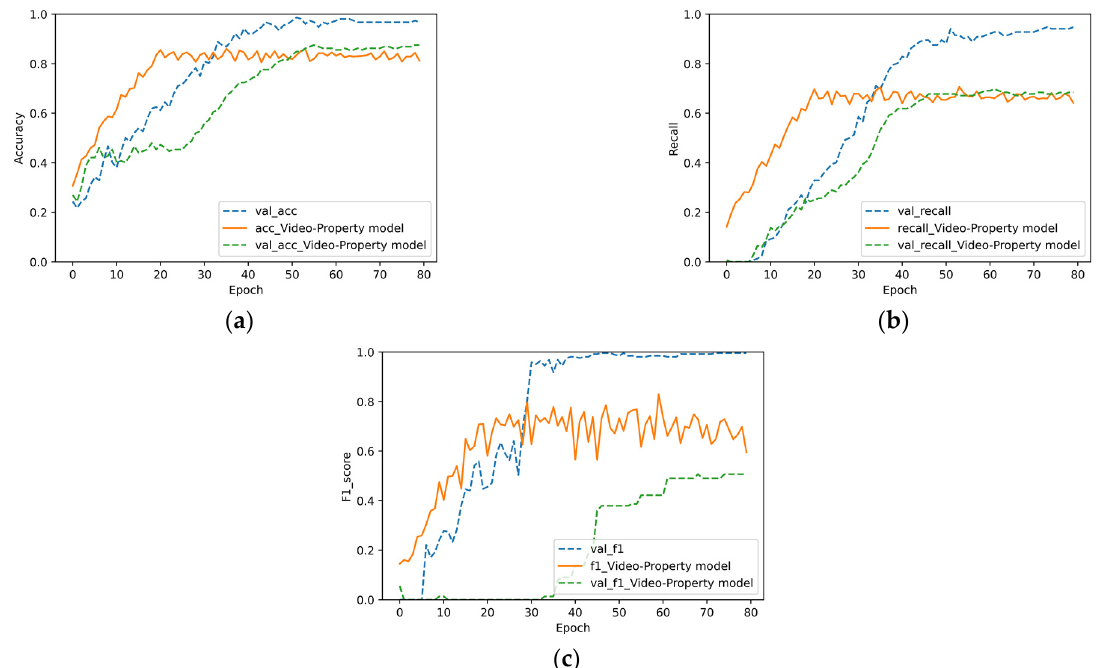
Figure 7. Experimental results of the video–review model: ( a ) accuracy, ( b ) recall, and ( c ) F 1 score.